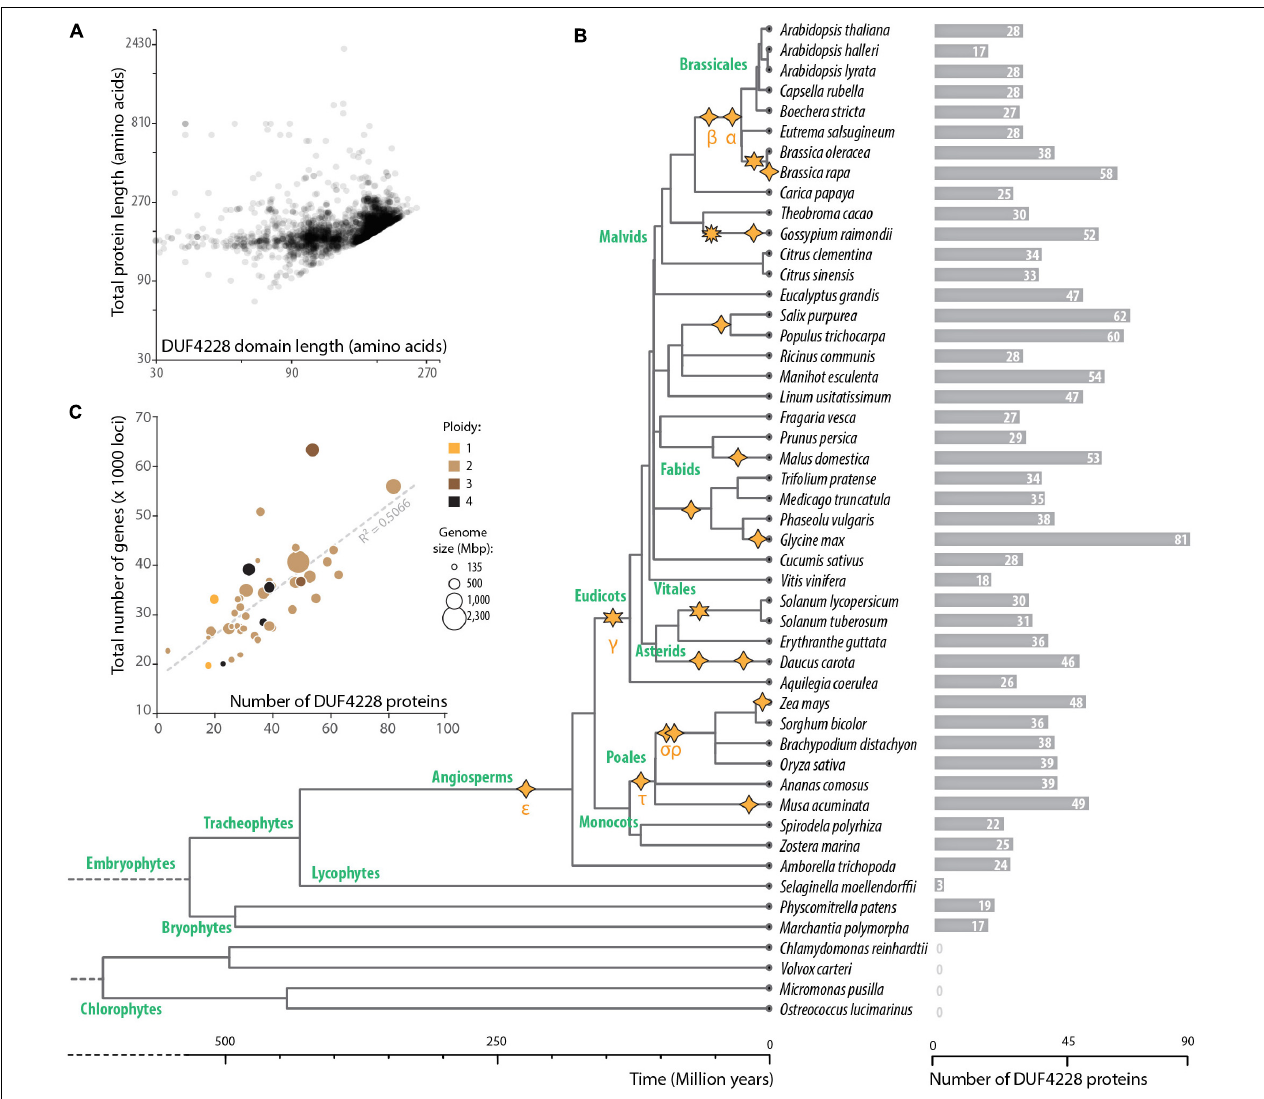
FIGURE 2 | Taxonomic distribution of DUF4228 domains. (A) Relationship between total protein length and DUF4228 domain length in 3647 proteins from the Refprot database. (B) Timetree and DUF4228 family size for plant species from the Phytozome 12.1 database. The phylogenetic tree and divergence time estimates were obtained using Kumar et al. (2017). Polyploidization events described in the literature (Wang et al., 2019; Xu et al., 2019) are shown as stars with 4 spikes (tetraploidy), 6 spikes (hexaploidy), or 10 spikes (decaploidy). Greek letters correspond to common names attributed to polyploidy events in the literature, starting with events identified in the Arabidopsis genome. (C) Relationship between DUF4228 family size and total genome size (number of protein-coding loci) in 45 embryophyte species. Bubbles are sized according to genome size in Mbp and colored according to ploidy